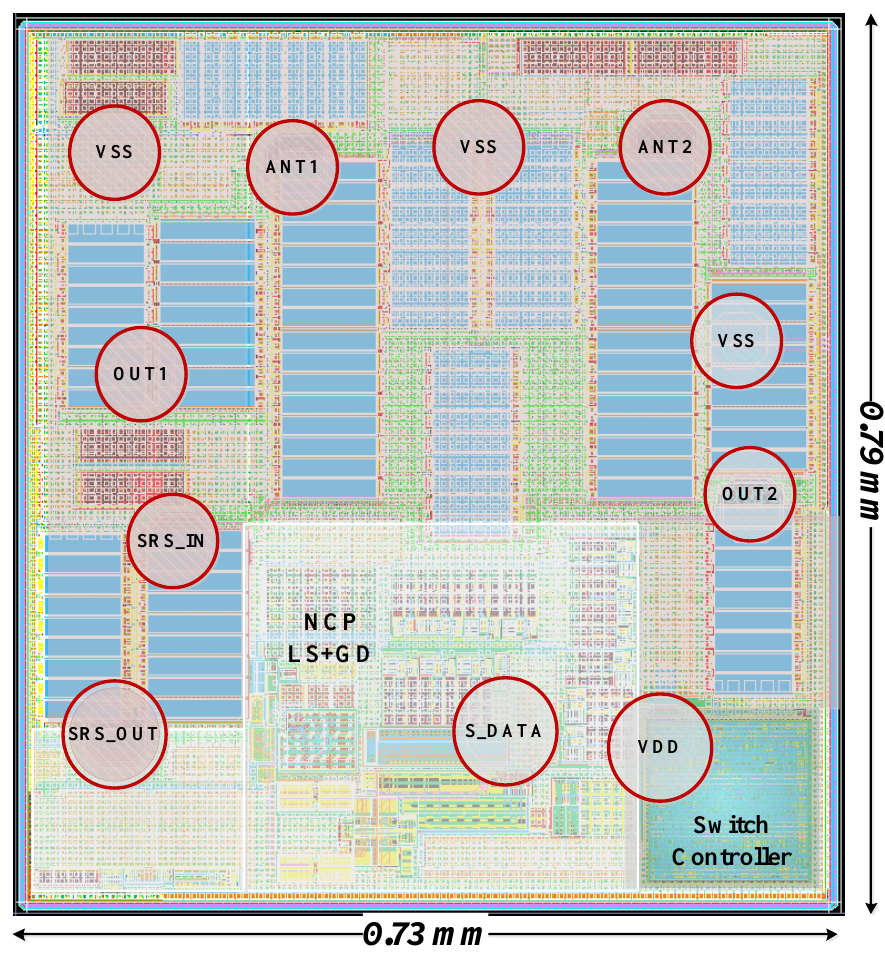
Figure 4. Layout pattern of the proposed 3P3T. Table 1. Summary of performance comparison.